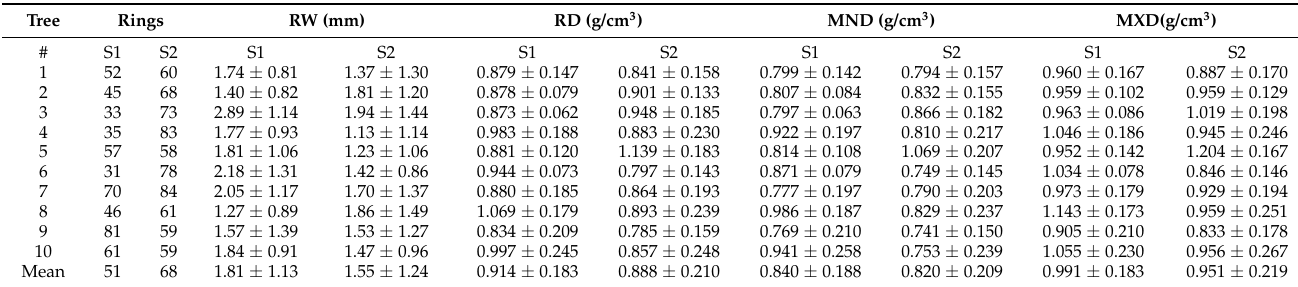
Table 3. Ring width (RW), ring density (RD), minimum (MND) and maximum ring density (MXD) for the studied Quercus rotundifolia trees at site 1 (S1) and site 2 (S2). Mean values of ten trees and standard deviation.